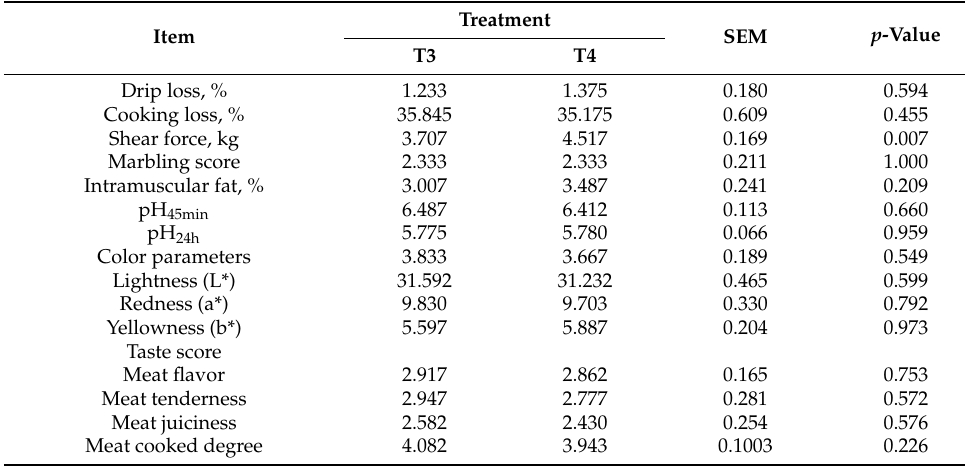
Table 8. Effect of dietary SID lysine levels on meat traits of Baqing